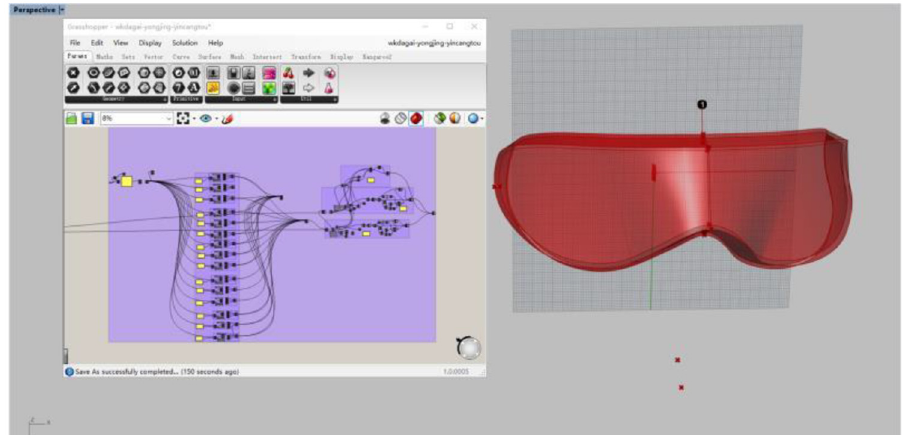
Fig. 9. Parametric model of swimming goggles.